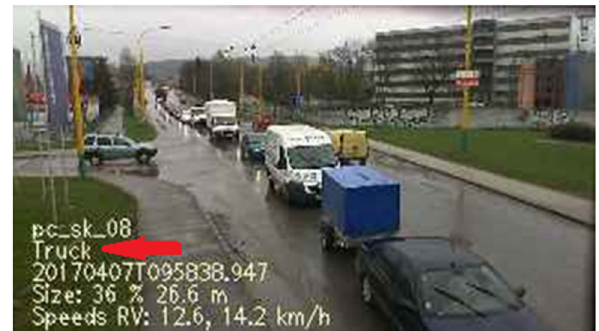
Figure 11: Incorrect vehicle classi fi cation [ 15 ] .